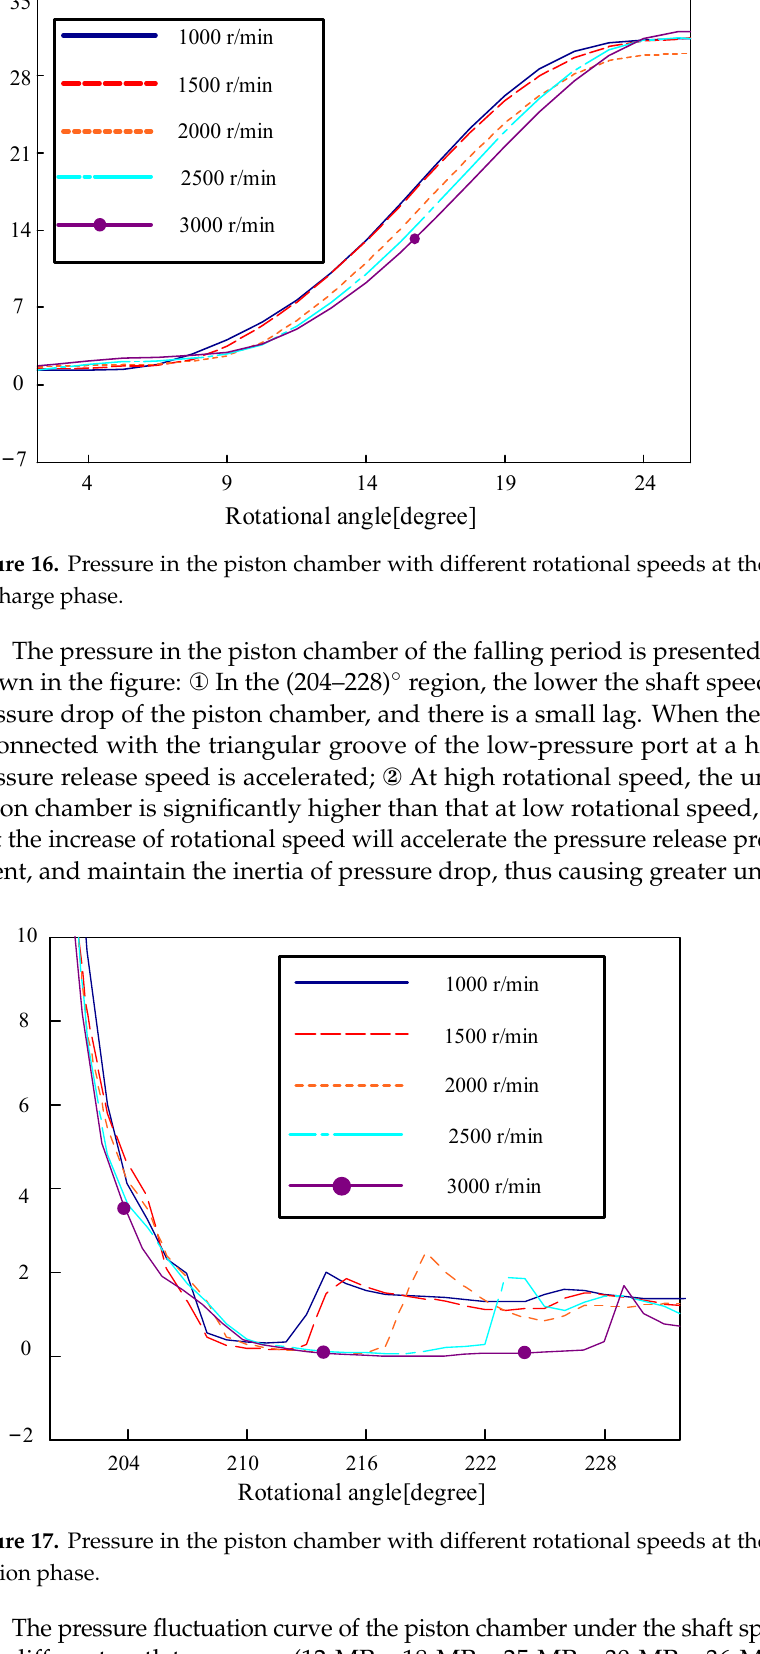
Figure 18. It can be seen from the figure that: the higher the pressure, the greater